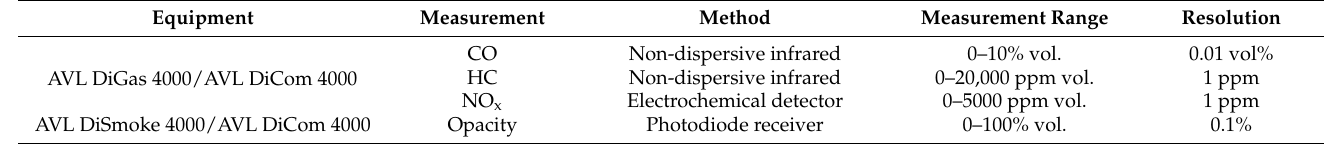
Table 5. Specifications of emission analyzer.